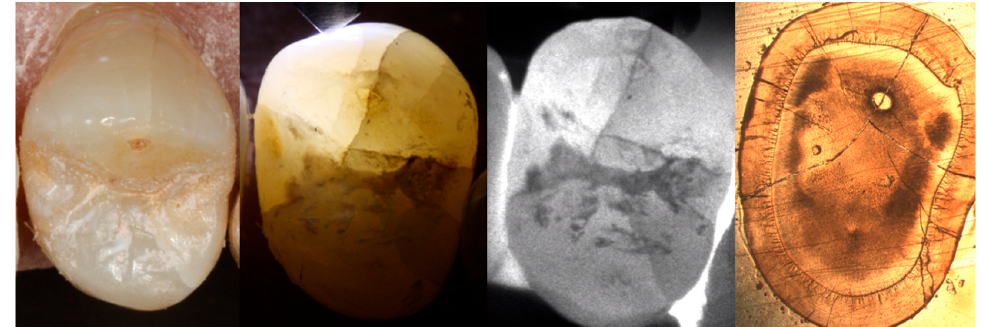
Figure 1. Visualization of cracks using a dental operating microscope, fiber-optic transillumination, near-infrared transillumination, and histological tooth sections under a digital light microscope (from left to right).